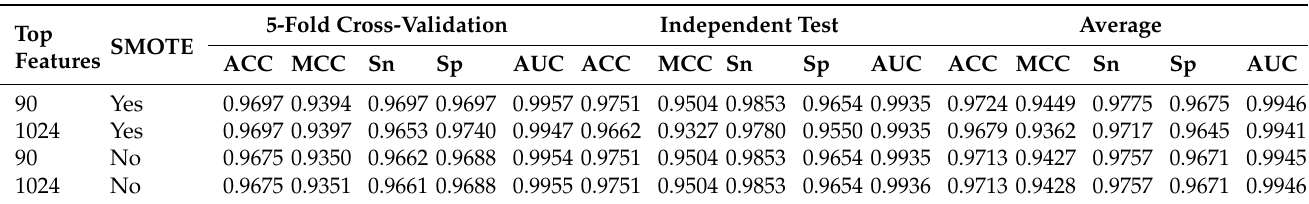
Table 2. Before or after feature selection and with or without the SMOTE, performance of the model on the independent test and